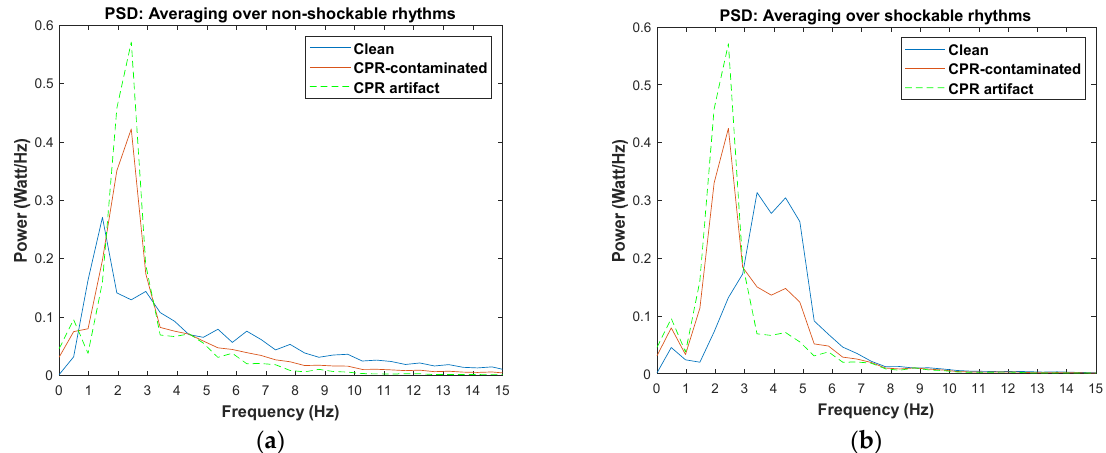
Figure 2. Averaged PSD of ( a ) non-shockable and ( b ) shockable ECG rhythms. In both figures, blue and red represent the PSD of clean ECG and CPR-contaminated ECG, respectively.